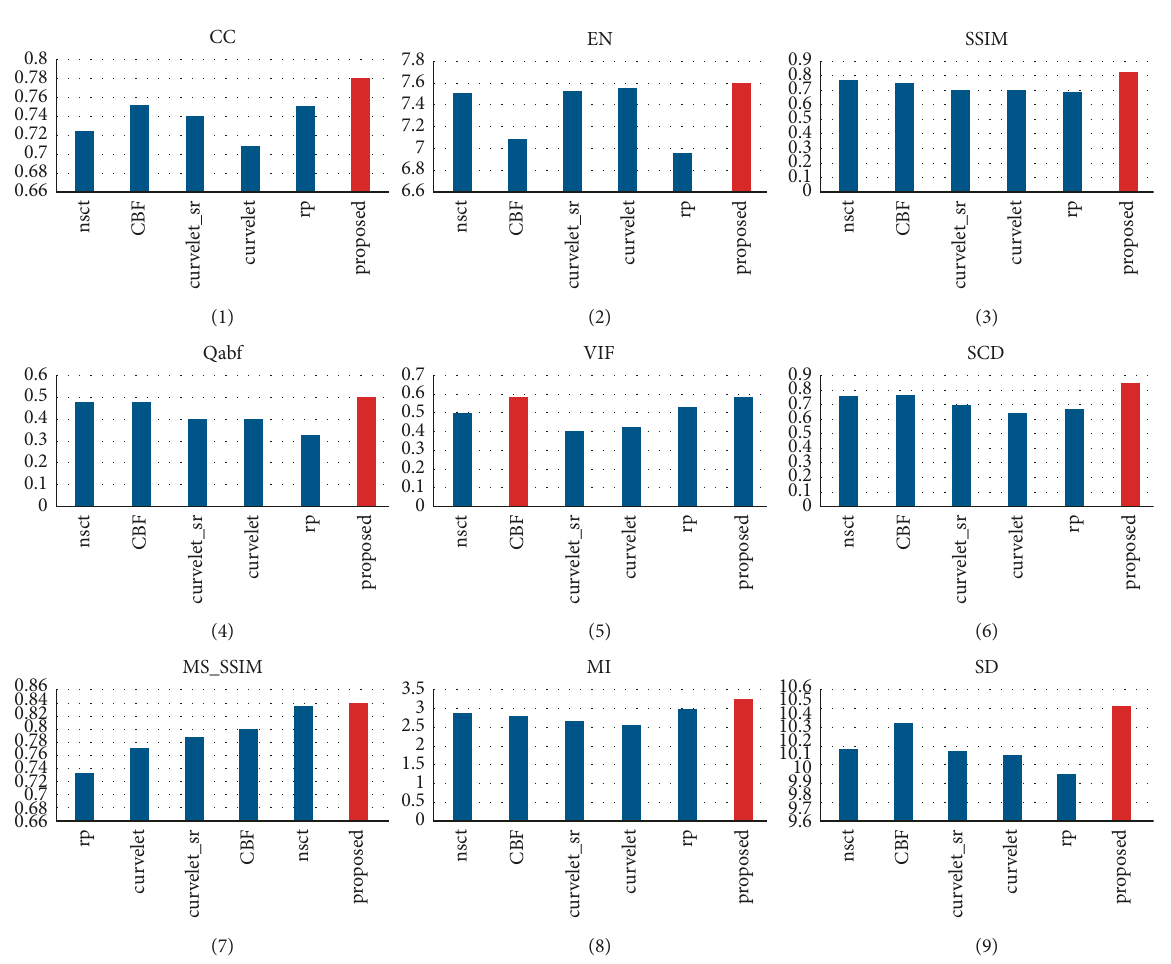
Figure 8: Comparison of the fusion results from different methods on the source